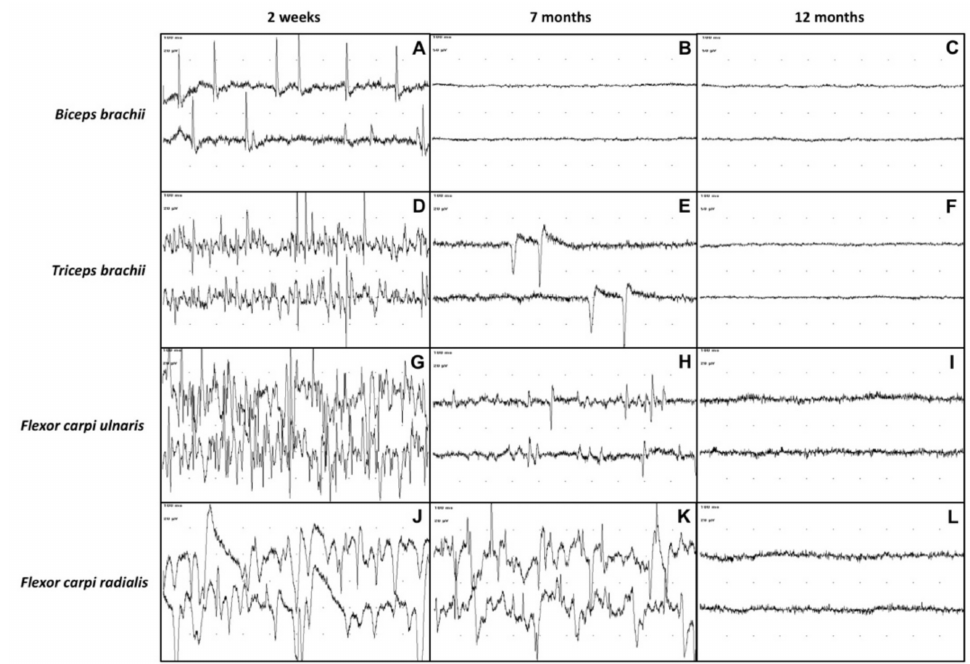
Figure 3. EMG recording of the left thoracic limb’s muscles ( biceps brachii, triceps brachii, flexor carpi ulnaris, flexor carpi radialis ) at 2 weeks, 7 months and 12 months after admission. Sweep speed: 10 ms/div. Biceps brachii muscle at 2 weeks ( A ), 7 months ( B ) and 12 months ( C ) after admission. Triceps brachii muscle at 2 weeks ( D ), 7 months ( E ) and 12 months ( F ) after admission. Third row: Flexor carpi ulnaris muscle at 2 weeks ( G ), 7 months ( H ) and 12 months ( I ) after admission. Flexor carpi radialis muscle at 2 weeks ( J ), 7 months ( K ) and 12 months ( L ) after admission. An evident reduction of spontaneous pathologic activity can be observed at 7 months after admission up to normalization of EMG tracings in all the recorded muscles at 12 months after